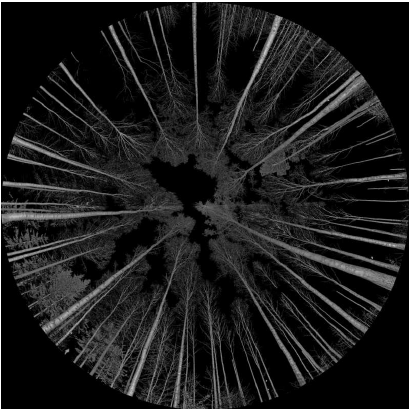
Figure 4: Hemispherical projection of the 3D point cloud